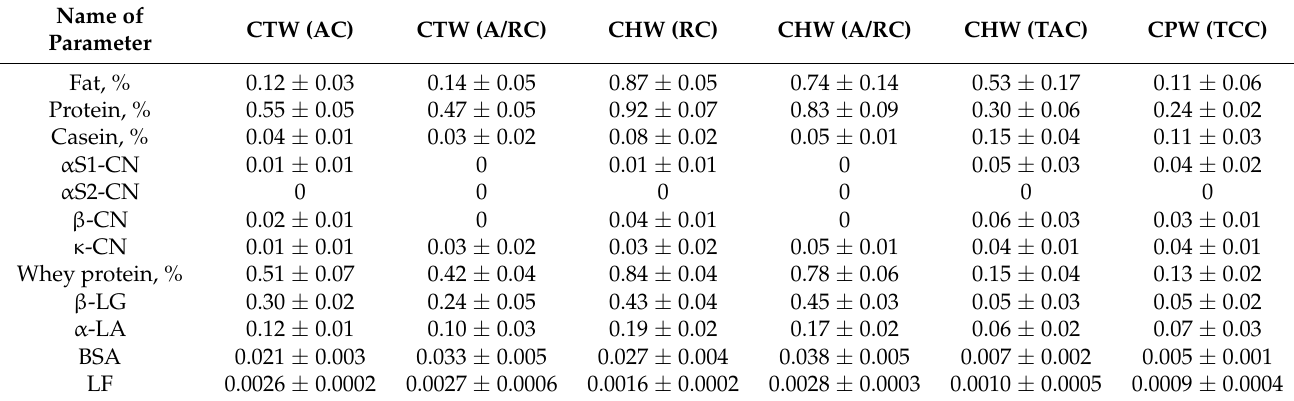
Table 1. Protein profile and physico-chemical properties of milk